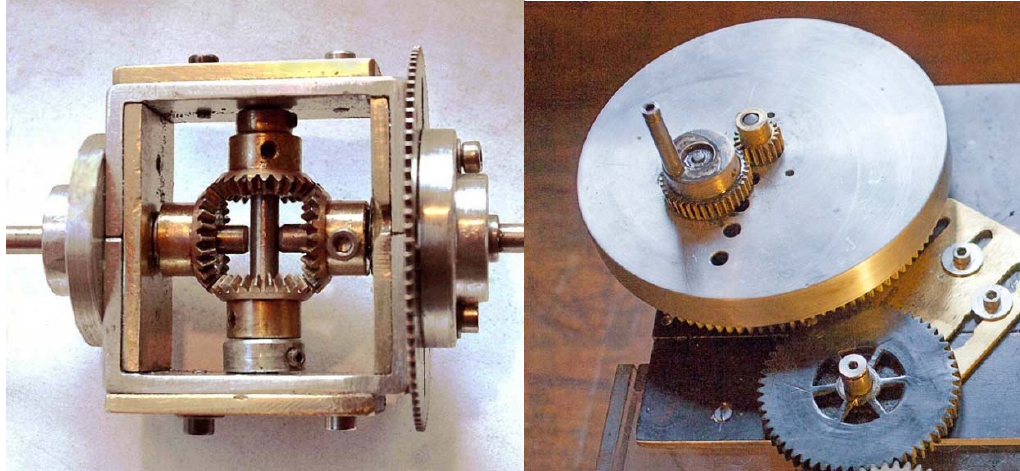
Figure 3. Showing the differential crown wheel and the sun and planet drive on the X axis.